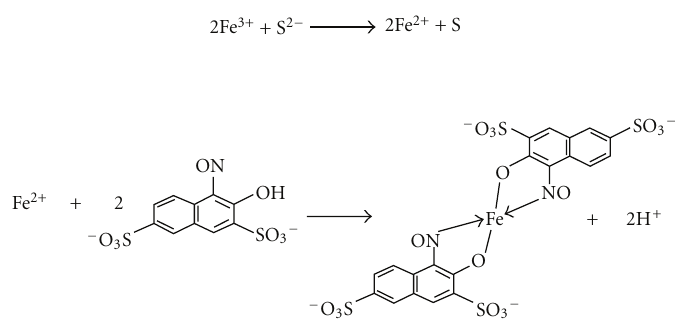
Scheme 1: Species responsible for color formation.